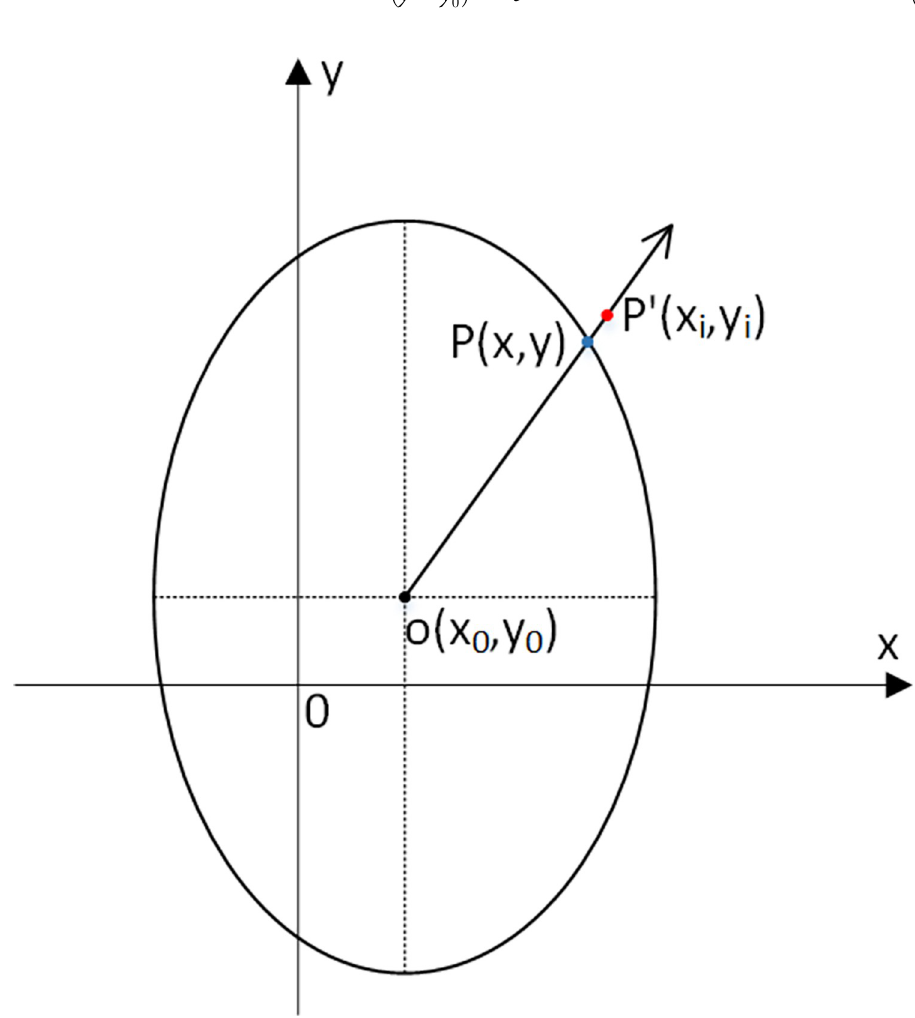
Fig 5. Relationship between the identified ship domain model boundary and AIS